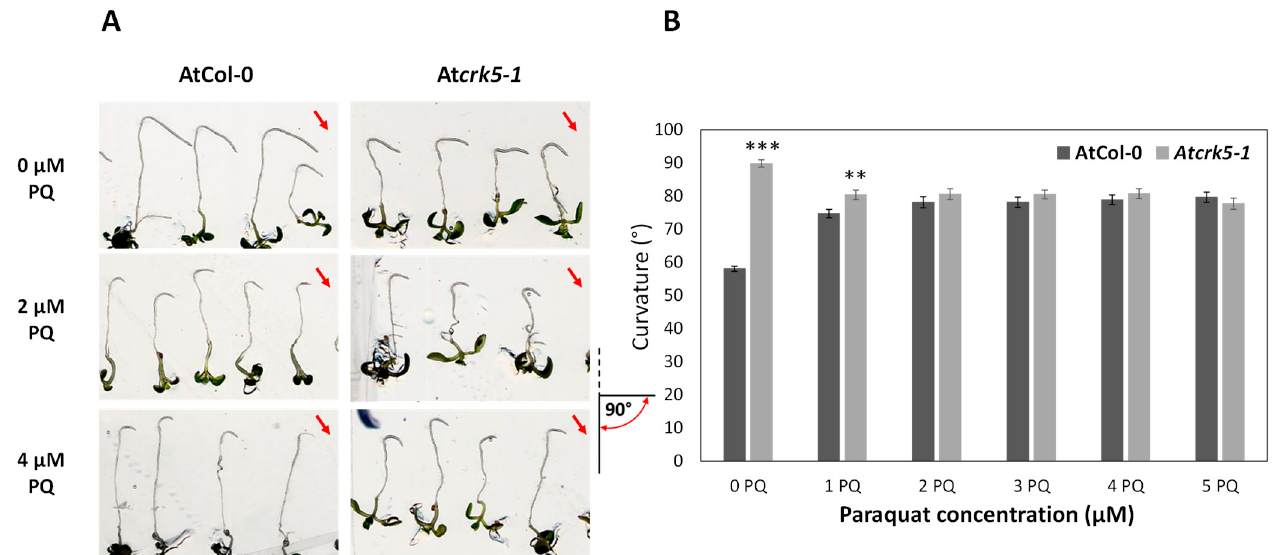
Figure 2. Effects of PQ on root gravitropic response. ( A ) Seedlings were grown vertically for 5 days, then they were transferred into media containing different PQ concentrations and were immediately rotated by − 135°. The pictures were taken 24 h after gravistimulation. Red arrows indicate the direction of the gravity vector. The pictogram at the lower right corner of the Figure 1A shows the mode of the determination of the root curvature degree, the red semicircle with arrows indicates the measured angle ( B ) Quantitative analysis of PQ’s effect on the curvature of the gravistimulated roots. After 24 h of gravistimulation, the degrees of root bends were measured for each line grown at the various PQ concentrations (0–5 µM). Asterisks indicate significant differences between the wild type (AtCol-0) and mutant (At crk5-1 ) roots at ** p < 0.01 or at *** p < 0.001, respectively. Measurements were performed with at least 30 seedlings per each concentration. Bars indicate standard error. Three biologically independent experiments were carried out with the same statistical results.